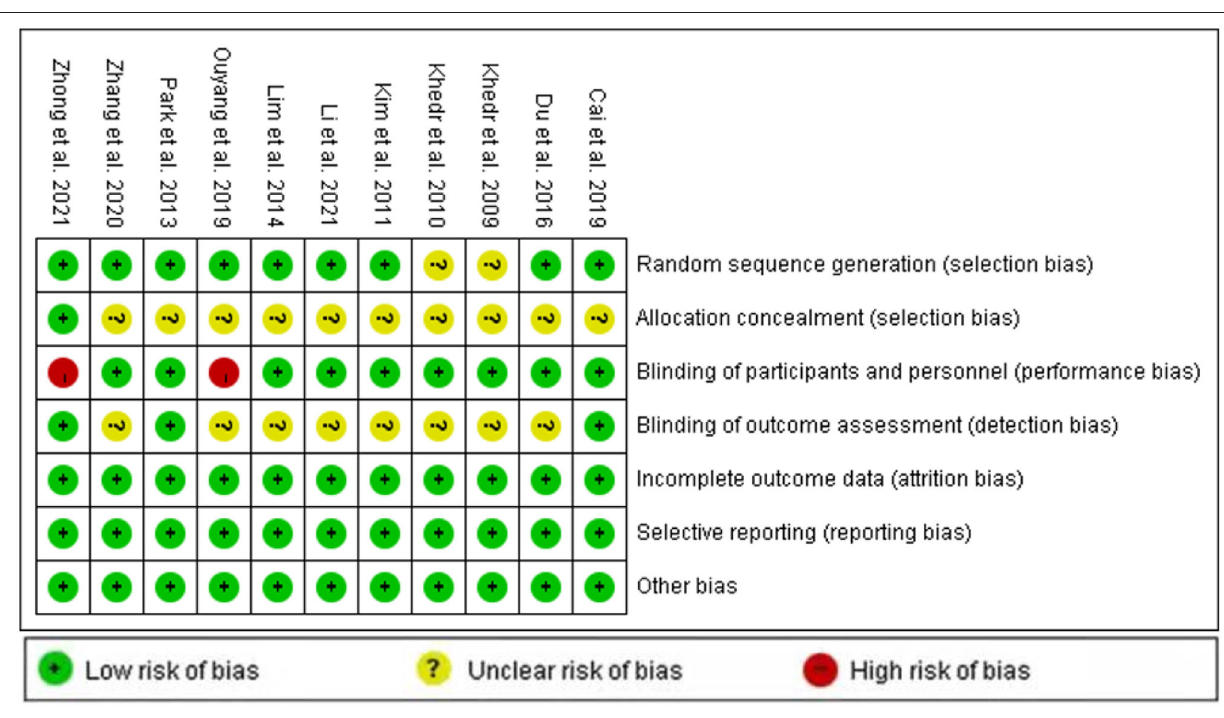
FIGURE 3 | Risk of bias assessment for 11